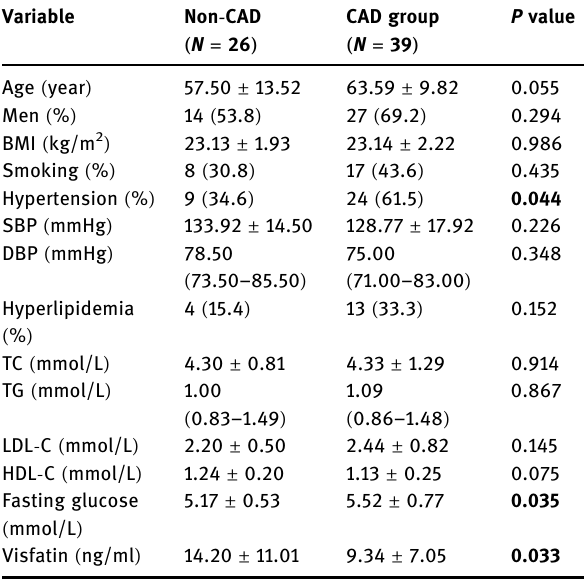
Table 1: Baseline characteristics of study subjects